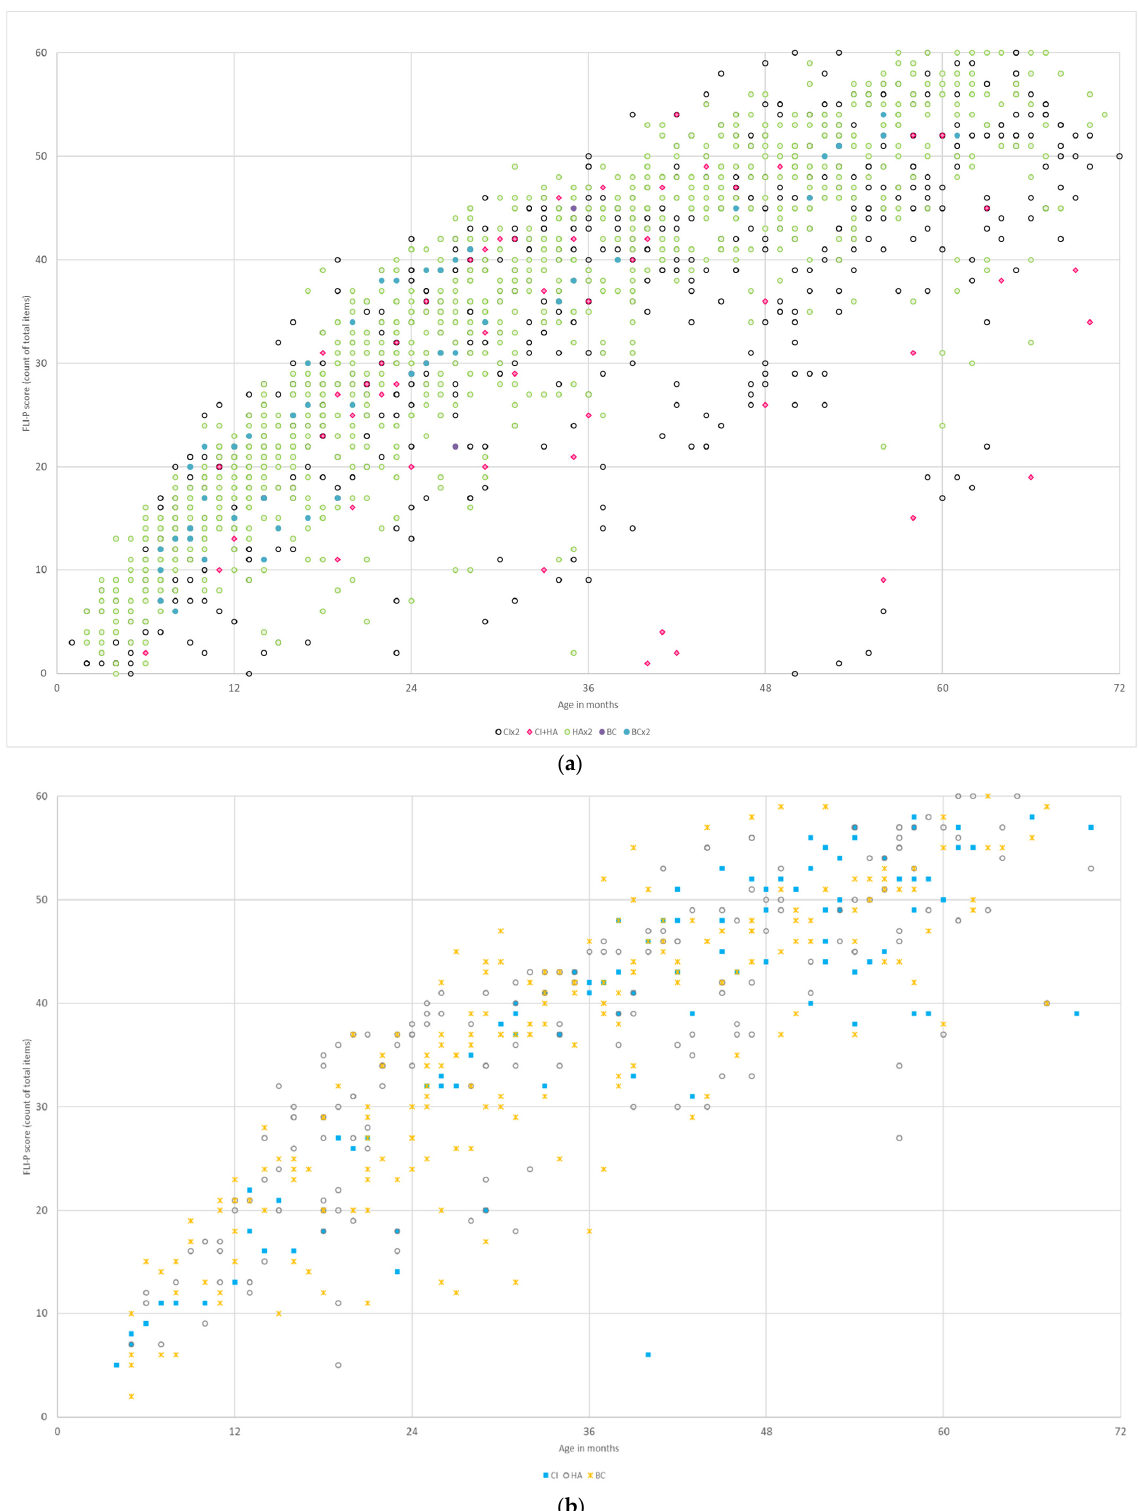
Figure 11. FLI-P scores by device for children with ( a ) bilateral hearing loss with bilateral cochlear implants (no color), a cochlear implant and a hearing aid (red), bilateral hearing aids (green), a bone conduction device (black), and bilateral bone conduction devices (blue); and ( b ) unilateral hearing loss with a cochlear implant (blue), a hearing aid (no color), and a bone conduction device (yellow). There were no observable patterns in either group.